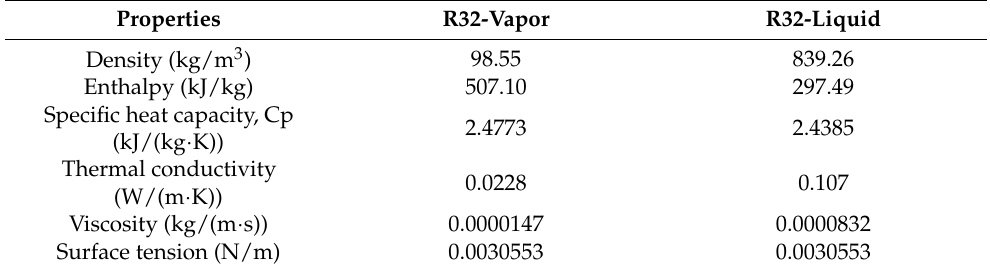
Figure 1. Geometric model of the simulation domain. ( a ) HO tube; ( b ) horizontally oriented tube with U-bend. Table 1. Thermophysical properties of R32 at T sat = 323.15 K and P sat = 3.1412 MPa.